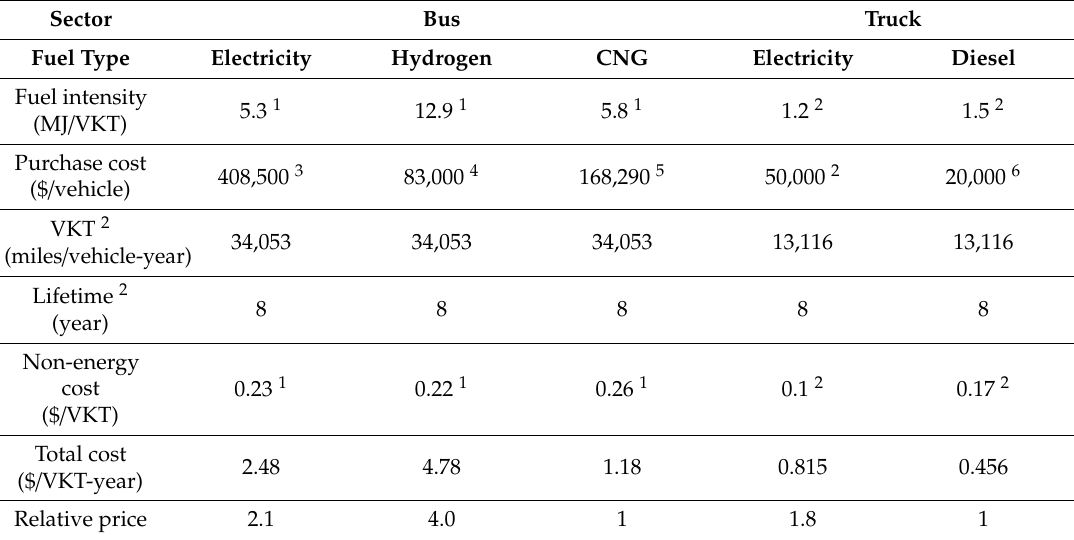
Table A4. Assumptions for an Electric Truck, Electric Bus, and Hydrogen